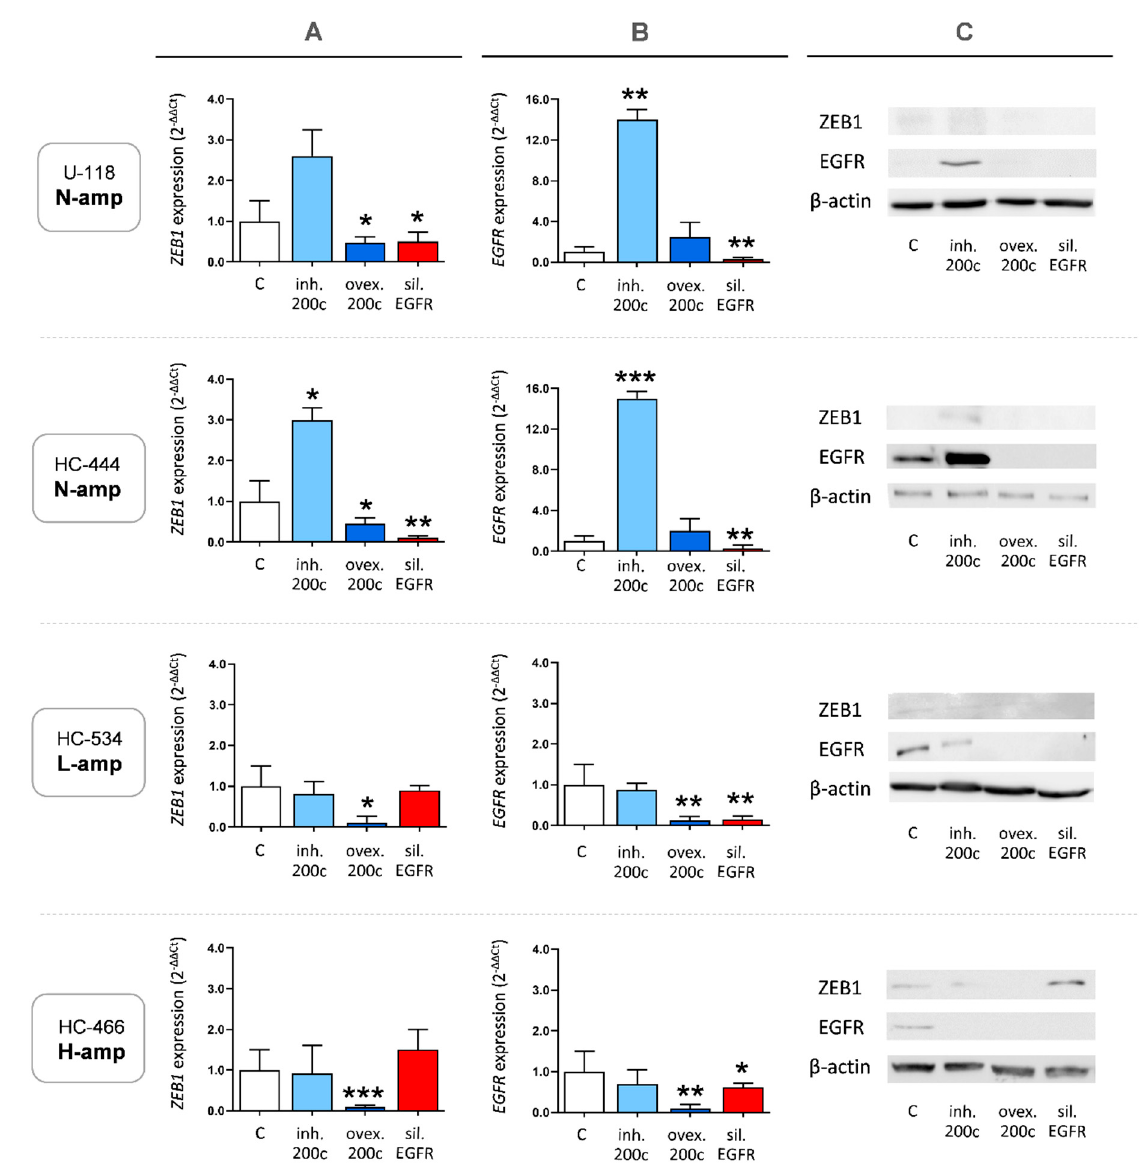
Figure 5. ZEB1 and EGFR expression analyses. ( A ) ZEB1 mRNA expression by qRT-PCR after performing cultures with four experimental conditions: without transfection (control), miR-200c inhibition, miR-200c overexpression and EGFR silencing. ( B ) EGFR mRNA expression by qRT-PCR after performing cultures with the four aforementioned experimental conditions. ( C ) ZEB1 and EGFR protein expression by Western blot after performing cultures with the four aforementioned experimental conditions. Changes in mRNA expression are reported as the mean and standard error with respect to the nontransfected culture using the 2- ∆∆ Ct method. All the experiments were performed three times. Statistical analyses were performed using one-way analysis of variance, followed by Dunnett’s t-test for multiple comparisons. Significant expression changes ( p ≤ 0.05 , p ≤ 0.01 and p ≤ 0.001 ) are marked with *, ** and ***, respectively. Results were normalized to the actin housekeeping gene.